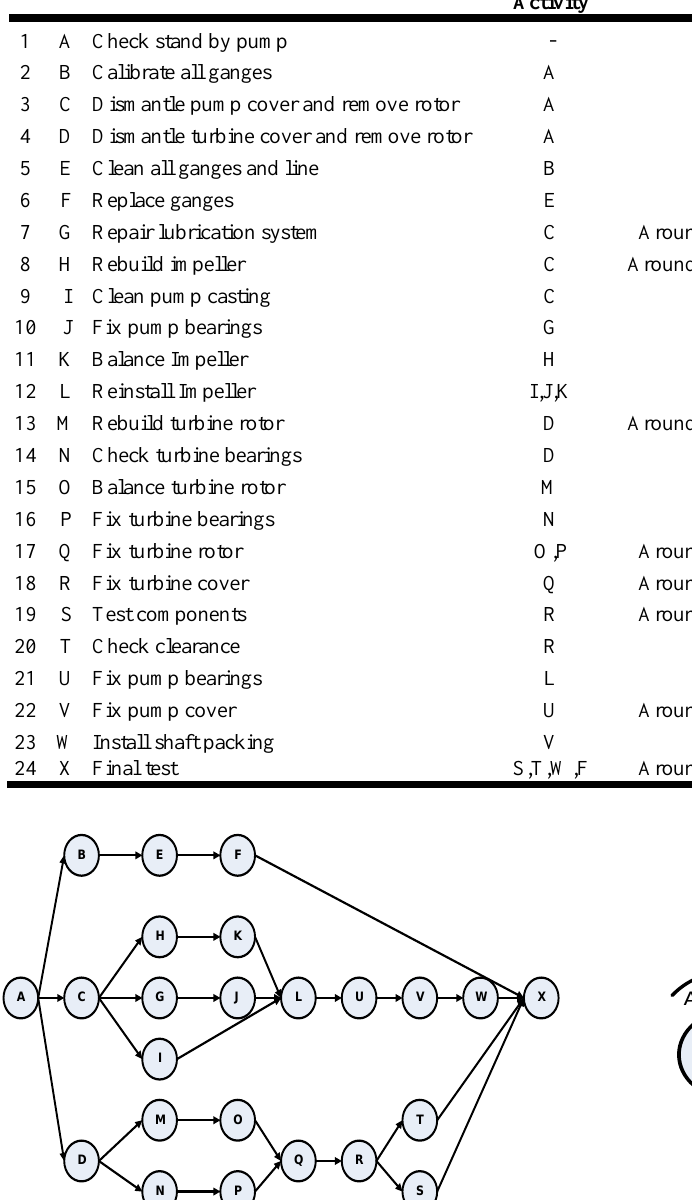
Table 1. The fuzzy activity time in the aircraft gas turbine engine repair/overhaul operations network shown as Figure 1 No.